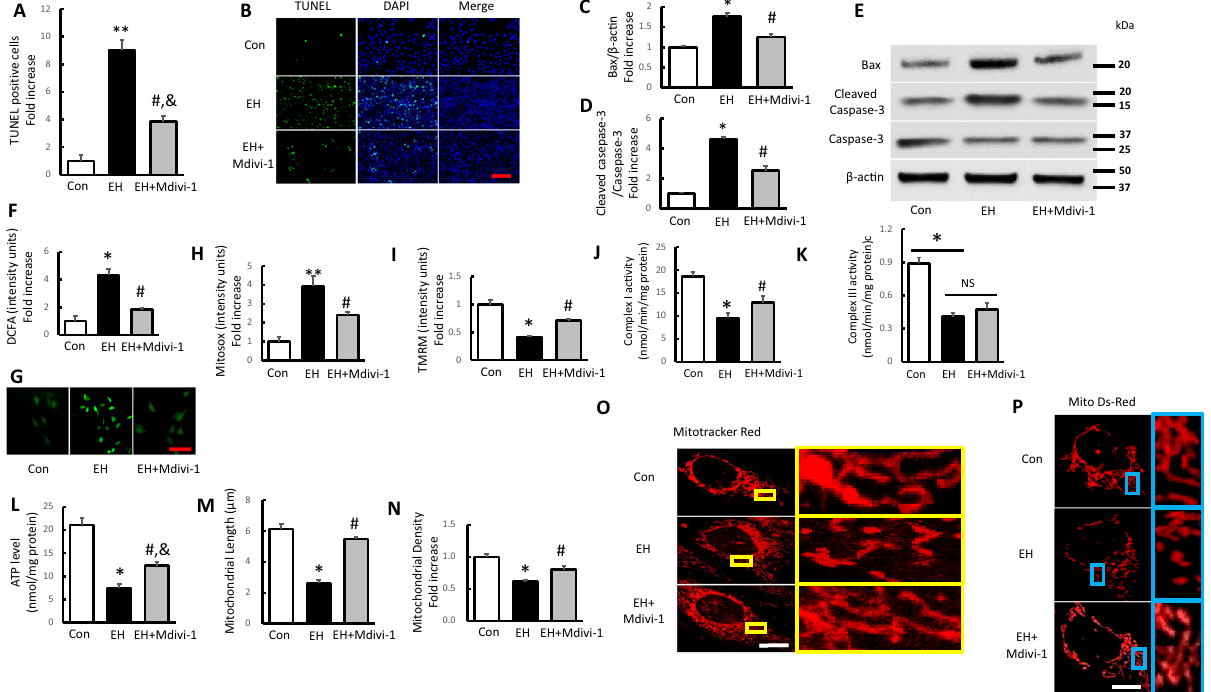
Figure 7. Treatment with mitochondrial division inhibitor Mdivi-1 rescues EH-induced apoptosis and mitochondrial dysfunction in SH-SY5Y cells. ( A , B ) The TUNEL-positive cells presenting as fold increase and representative pictures for TUNEL/DAPI-fluorescence staining (scale bar 200 μm) in indicated groups. ( C – E ) Quantification of immunoreactive bands for Bax relative to β-actin ( C ) and cleaved Caspase-3 relative to Caspase-3 ( D ). Immunoreactive bands for Bax, cleaved Caspase-3, and Caspase-3 in the different treated cells ( E ). ( F , G ) Quantitative analysis of DCFA fluorescence intensity presenting as fold increase and representative images (scale bar 50 μm) in the indicated groups. ( H , I ) Quantification of TMRM, Mitosox staining intensity presenting as fold increases in the indicated groups. ( J – L ) Complex I, III activities and ATP levels in the indicated groups. ( M – P ) Quantification of mitochondrial length and density with representative images of Mitotracker Red and Mito Ds-Red staining (scale bar 5 μm) in the indicated groups. Values shown as mean ± SD. *p < 0.05 and **p < 0.01 versus control group; # p < 0.05 versus EH group and & p < 0.05 versus control group (n =